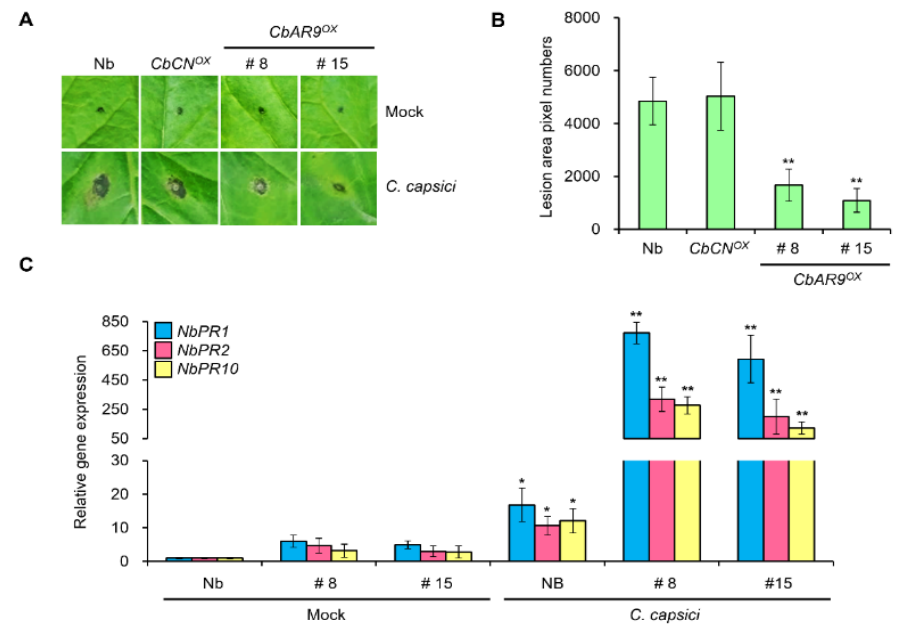
Figure 3. Overexpression of CbAR9 enhances resistance to anthracnose disease caused by Colletotrichum capsici infection. ( A , B ) Anthracnose disease resistance assays of CbAR9 OX Nicotiana benthamiana plants. 4-week-old CbAR9 OX and wild-type plants were inoculated with C. capsici . Images were captured after 6 days ( A ), and the progression of the disease was quantified using the image-based plant disease phenotyping method ( B ). Scale bars: 1 cm. Data are shown as means ± SD. Asterisks indicate statistical difference from controls (* p < 0.05). ( C ) Relative NbPR transcript levels in CbAR9 OX N. benthamiana plants after C. capsici inoculation, as determined by RT-qPCR. NbActin served as internal reference. Data are shown as means ± SD. Asterisks indicate statistically significant differences from controls (* p < 0.05 and ** p < 0.01). The experiments were repeated at least three times, with similar results.